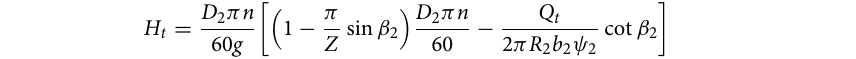
Orthogonal test scheme design and numerical calculation. Orthogonal Test Factors. Under the